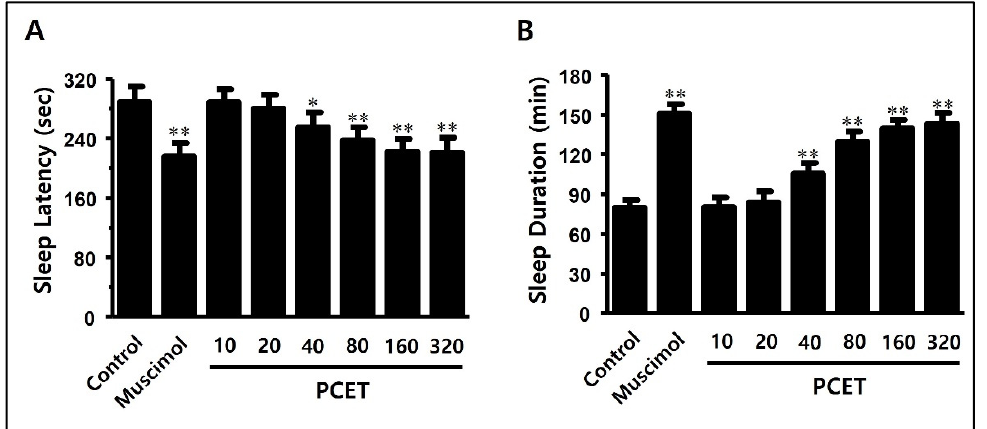
Figure 6. Effect of PCET on pentobarbital-induced sleep latency and sleep duration in normal mice. PCET was administered by oral gavage at concentrations of 10, 20, 40, 80, 160, 320 mg/kg BW 45 min before the intraperitoneal injection (42 mg/kg) of pentobarbital. Muscimol (0.2 mg/kg), the GABA A receptor agonist, was injected intraperitoneally as a positive control. In the pentobarbital-induced sleep test, ( A ) PCET reduced the sleep latency concentration-dependently, and ( B ) increased the total sleep time. The data are marked as mean ± standard deviation. Each group consisted of 10 mice. Statistical significance was evaluated based on the p -value, and significant differences from the negative control were marked by * p < 0.01 and ** p < 0.001.